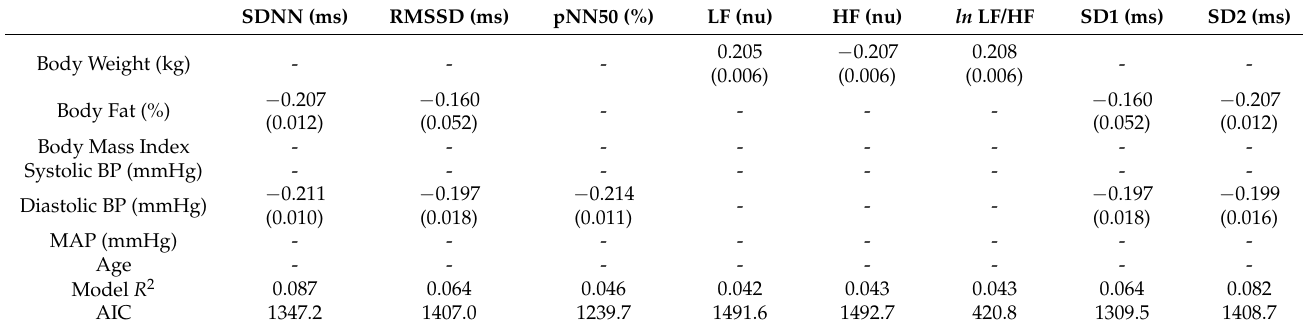
Table 3. Standardized regression coefficients ( p -values) for significant predictors in stepwise regression